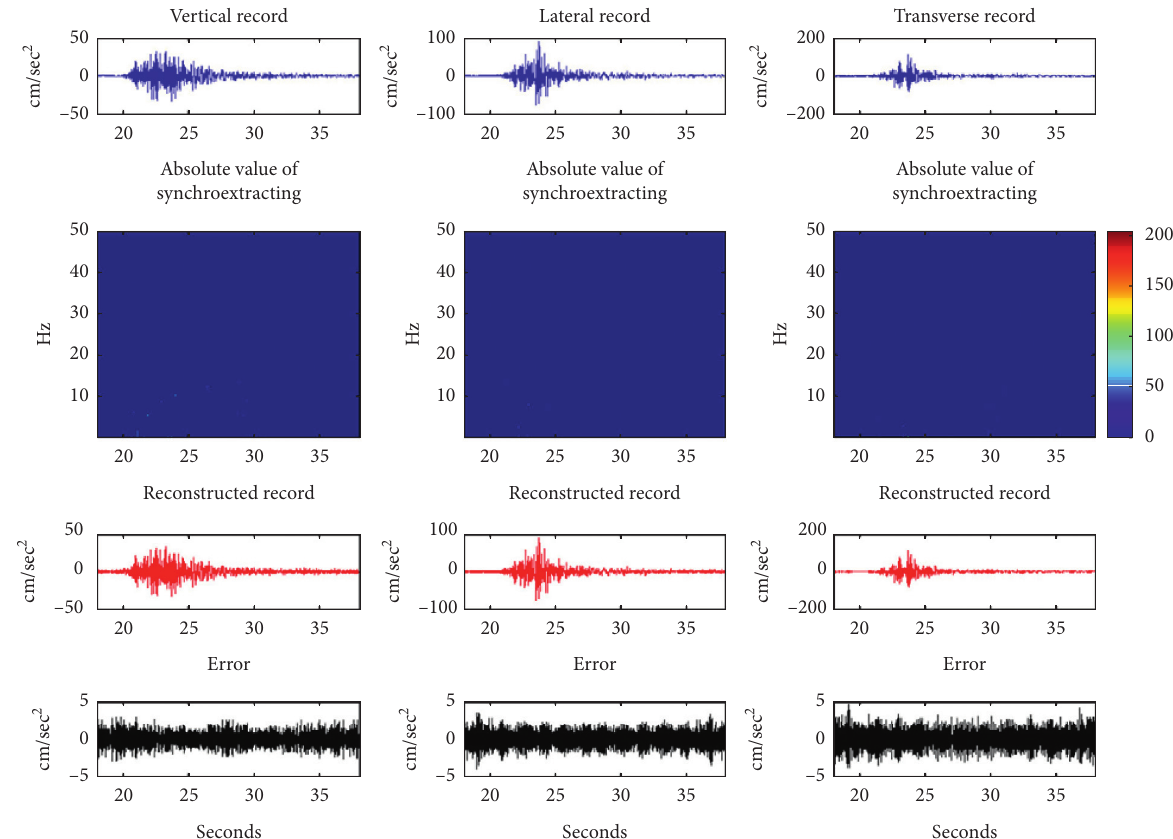
Figure 7: Synchroextracting transform analysis of the Mosha 2020 earthquake accelerograms recorded in Mosha3